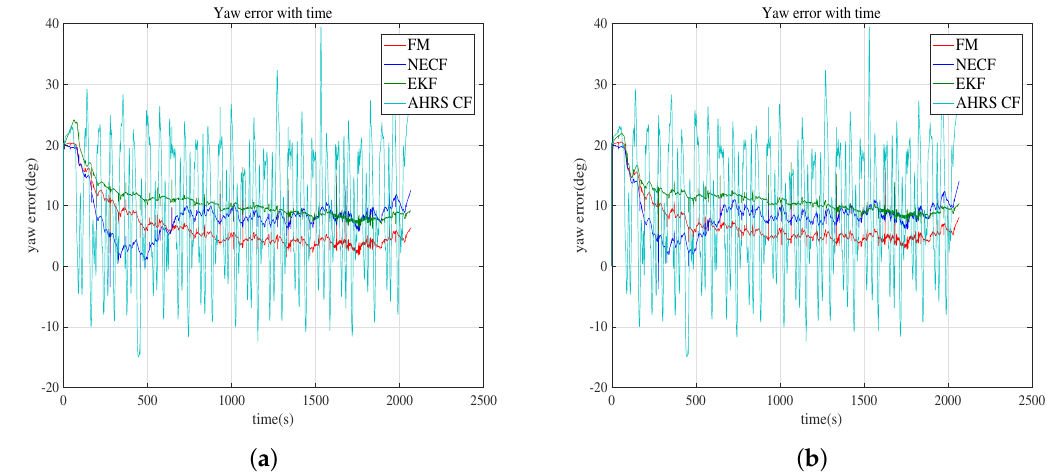
Figure 4. Error of estimated yaw with respect to the yaw provided by FOG is compared. ( a ) bias estimation is used; ( b ) bias estimation is not